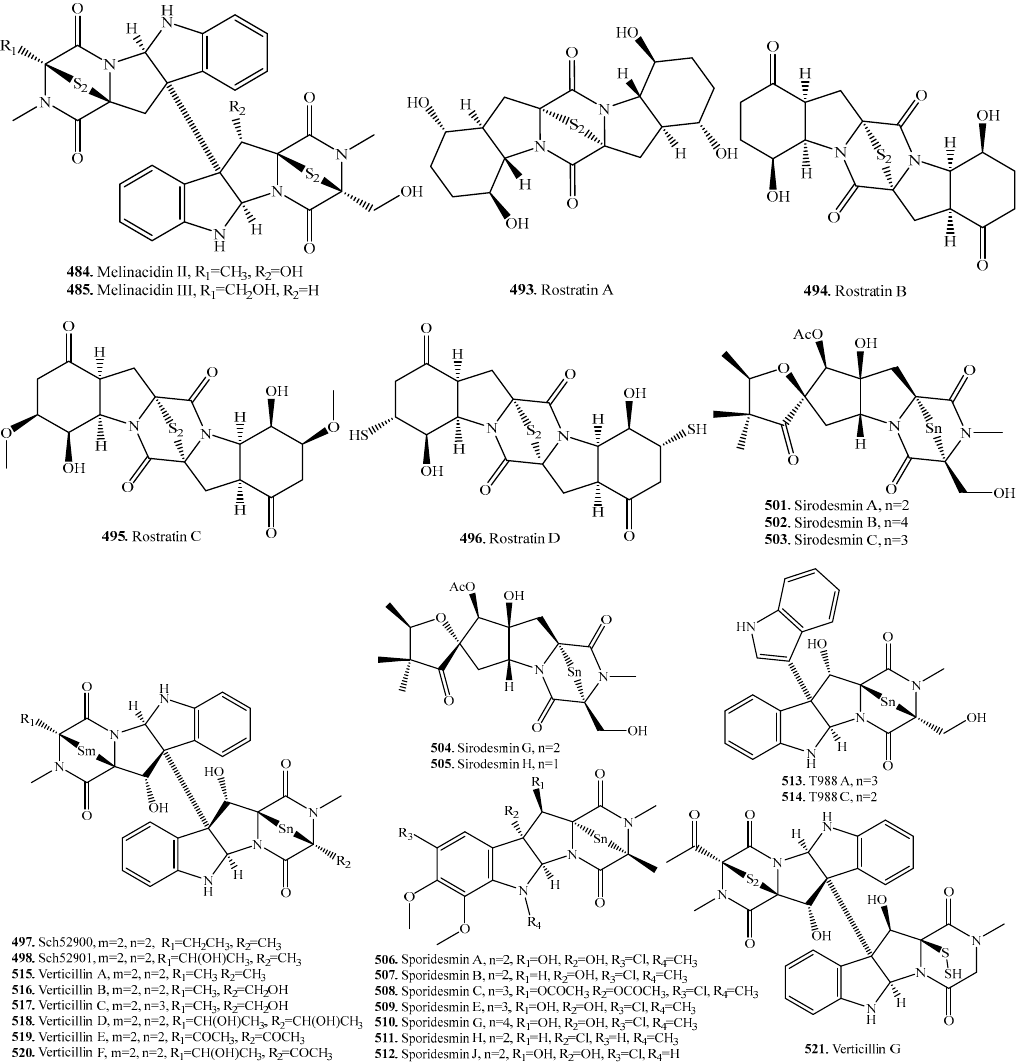
Figure 6. Structures of the 1,4-bridged epiplythiodioxopiperazine cyclodipeptide analogs isolated from